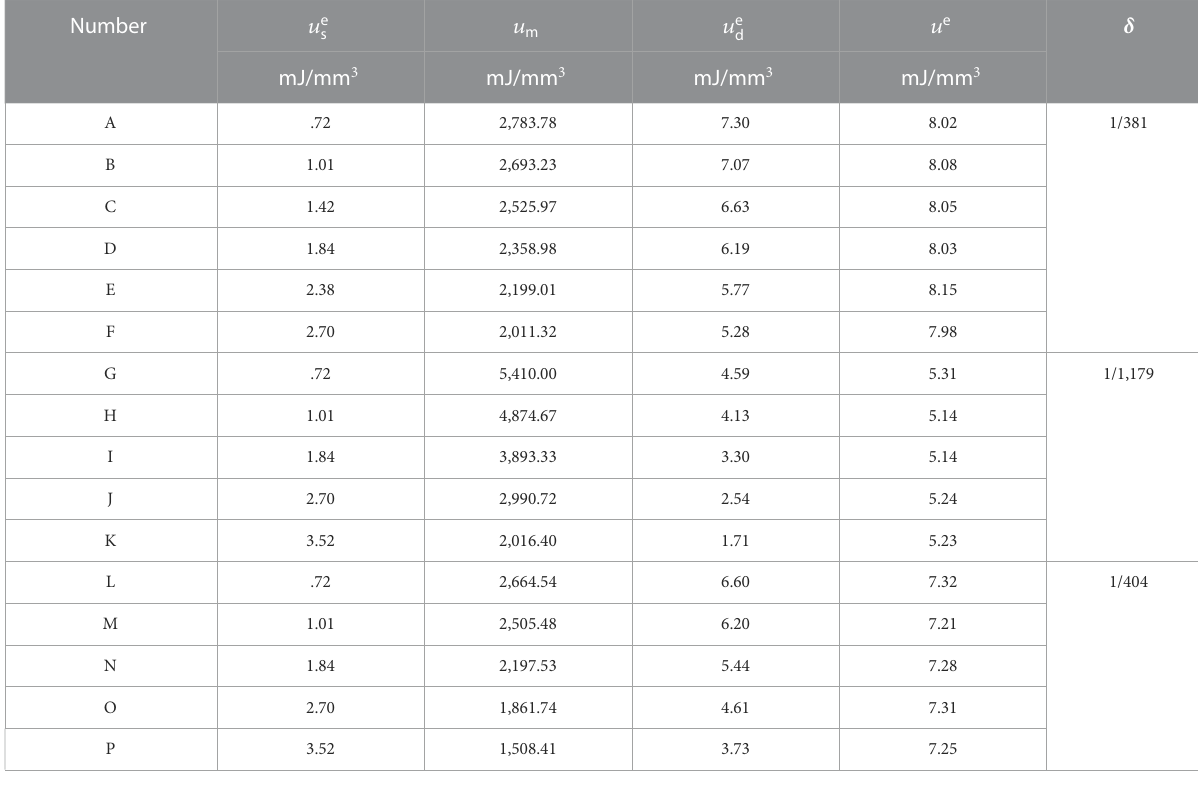
TABLE 8 Rock energy parameters.